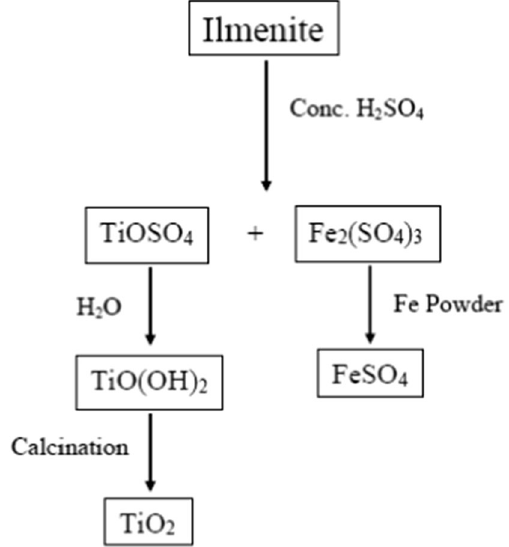
Fig. 5 The flow chart of syn- thesizing